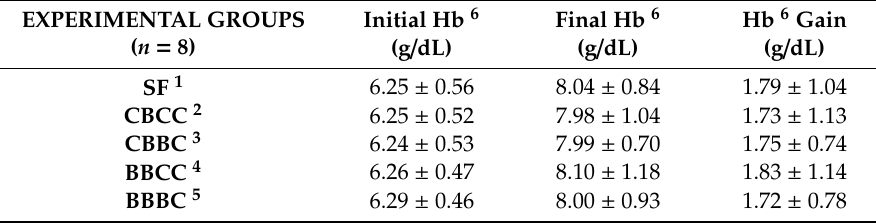
Table 6. Initialhemoglobin (Hb), final Hb, and Hb gain in the repletion phase.